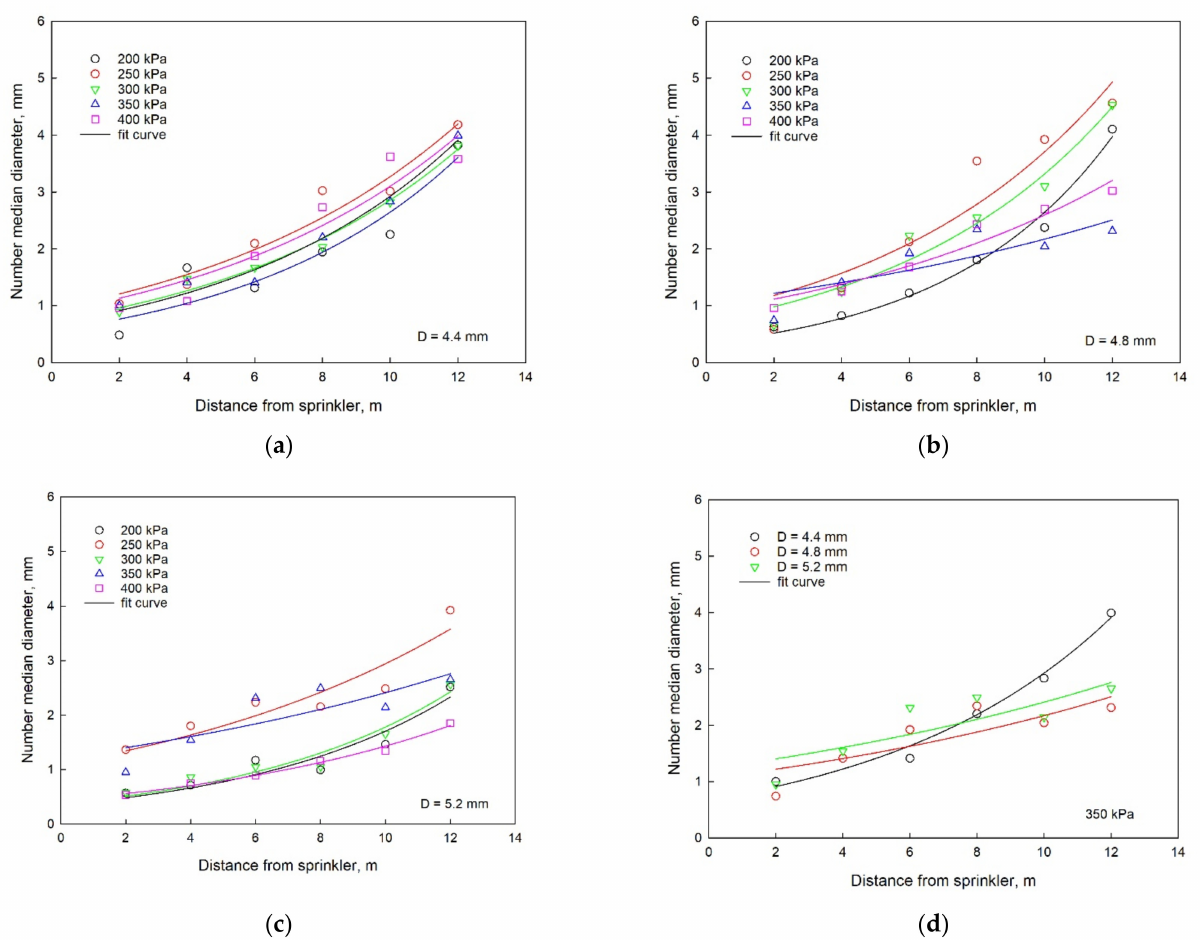
Figure 4. Relationships between the NMD and distance from the sprinkler under three different nozzle sizes of ( a ) D = 4.4 mm, ( b ) D = 4.8 mm, ( c ) D = 5.2 mm, and nozzle size of ( d ) under the working pressure of 350